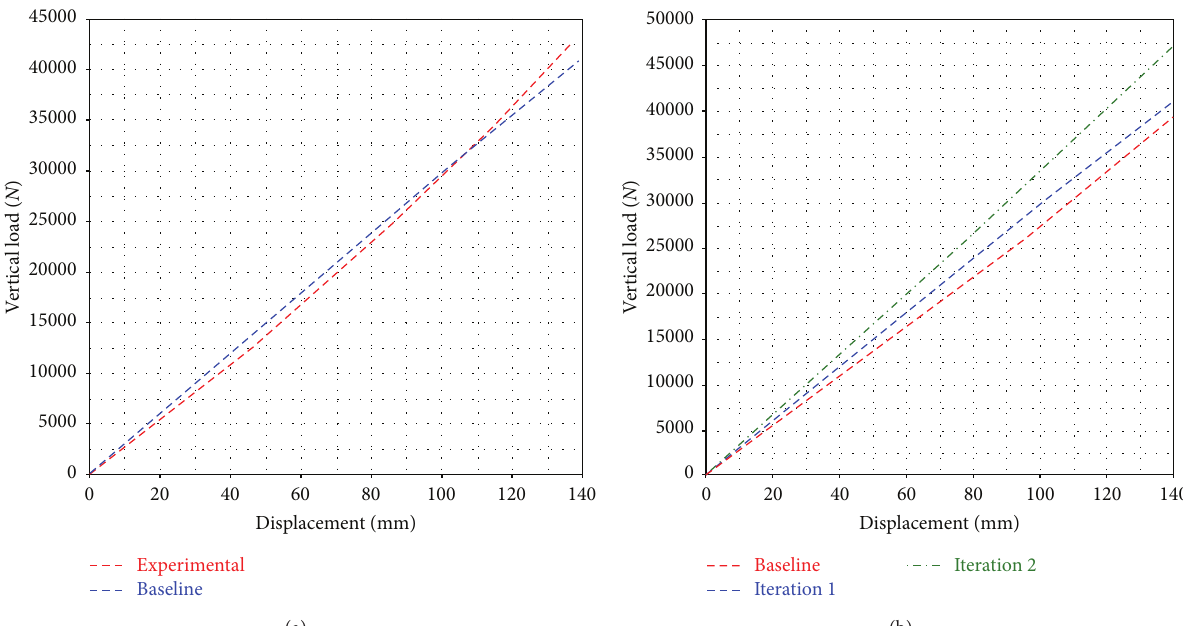
Figure 6: Graph of vertical stiffness comparison: (a) Baseline and experimental, (b) Baseline, Iteration 1, and Iteration 2.